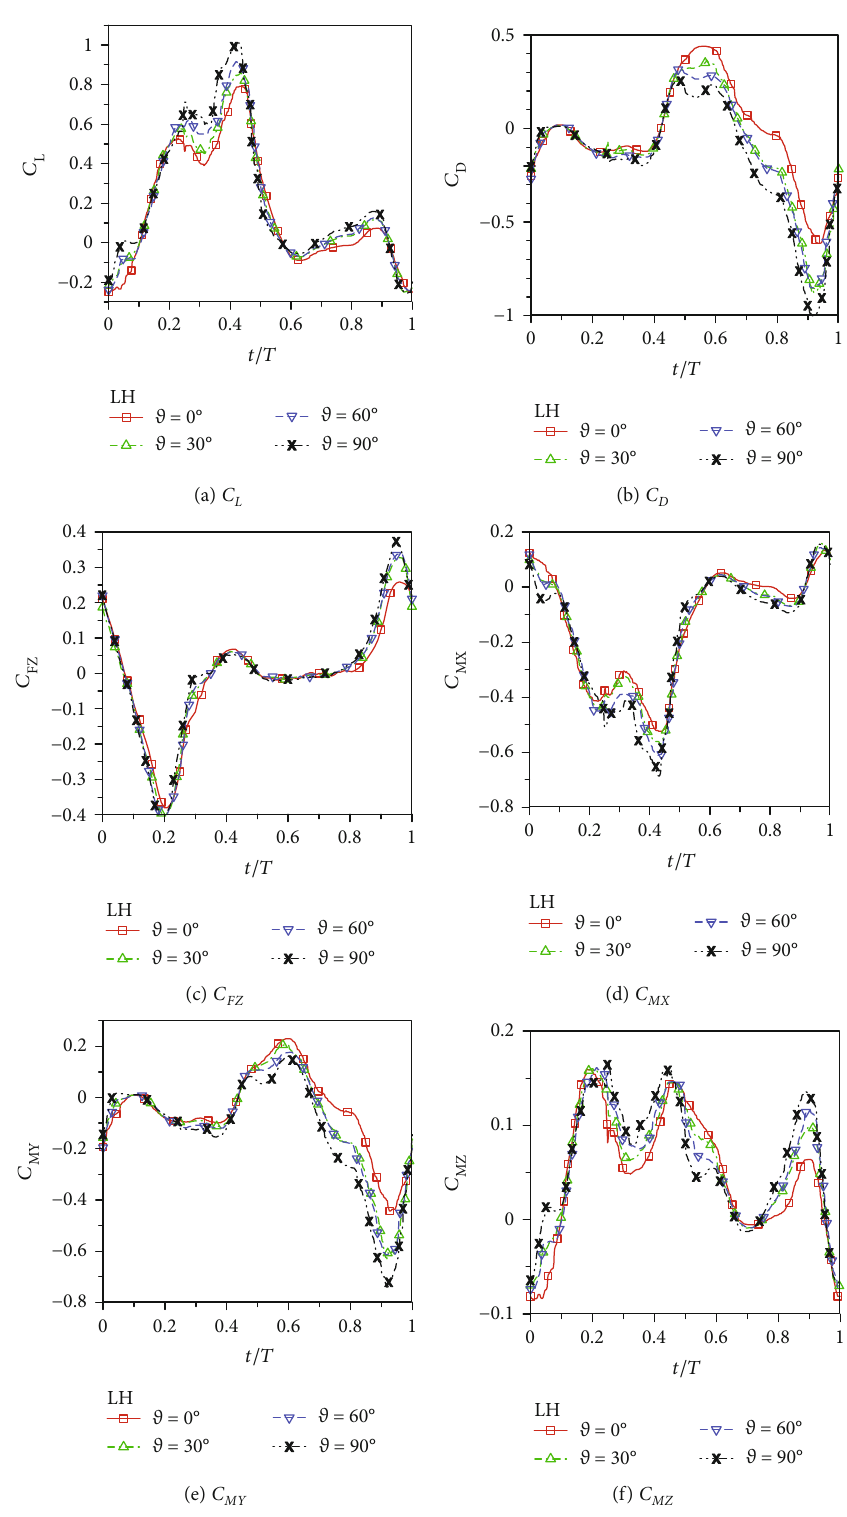
Figure 7: Coe ffi cients of instantaneous aerodynamic force and moment vs ϑ